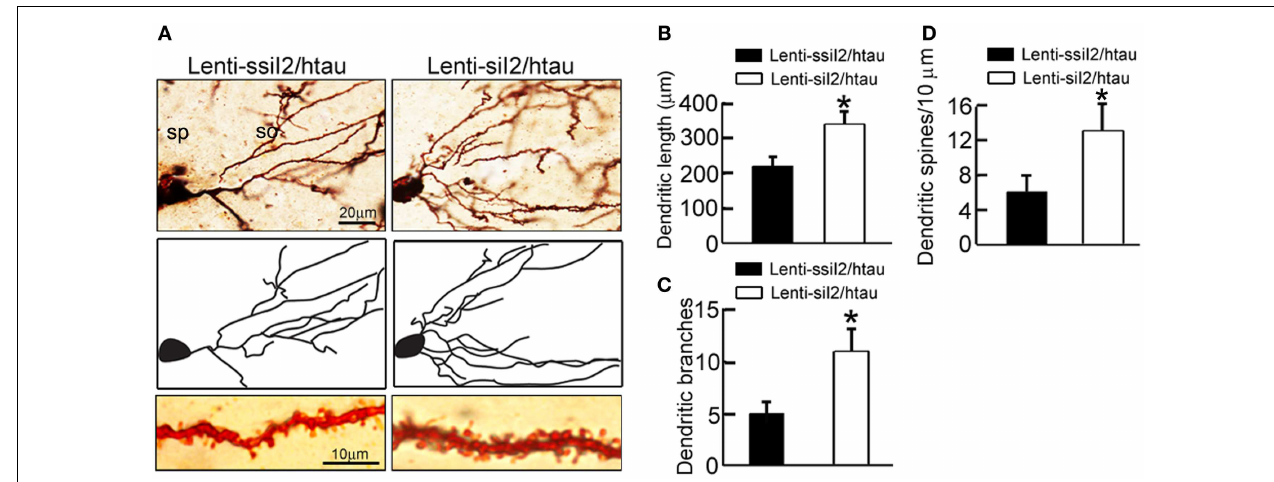
CA3 neurons with its corresponding morphological drawings (A) and FIGURE 4 | Expression of Lenti - siI PP2A remodels the dendrite complexity 2 quantitative analysis of the total dendrite length (B) , the number of dendritic in htau mice . Approximately 11-month-old htau mice received brain infusion of the Lenti - siI PP2A (Lenti-siI 2 ) or the scrambled Lenti - ssiI PP2A (Lenti-ssiI 2 ; 2 µ l branch (C) , and the density of dendritic spines (D) . So, stratum oriens; sp, 2 2 each, 2 × 10 9 TU/ml) into the hippocampal CA3 region under a stereotaxic stratum pyramidale.The data were expressed as mean ± SD. * p < 0.05; instrument. Four weeks later (A–D) , representative Golgi stained hippocampal